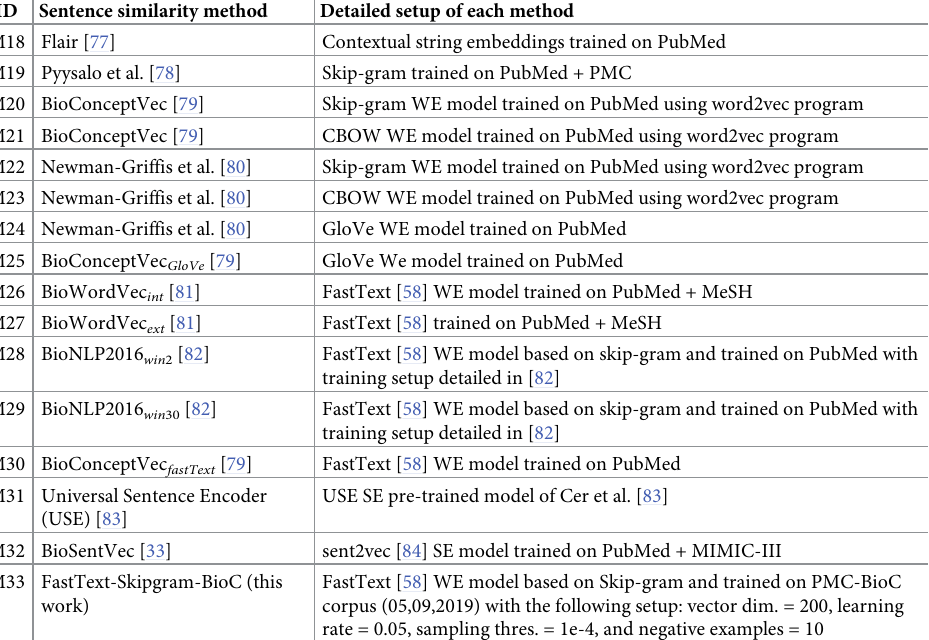
Table 4. Detailed setup for the sentence similarity methods based on pre-trained character, word (WE) and sen- tence (SE) embedding models evaluated